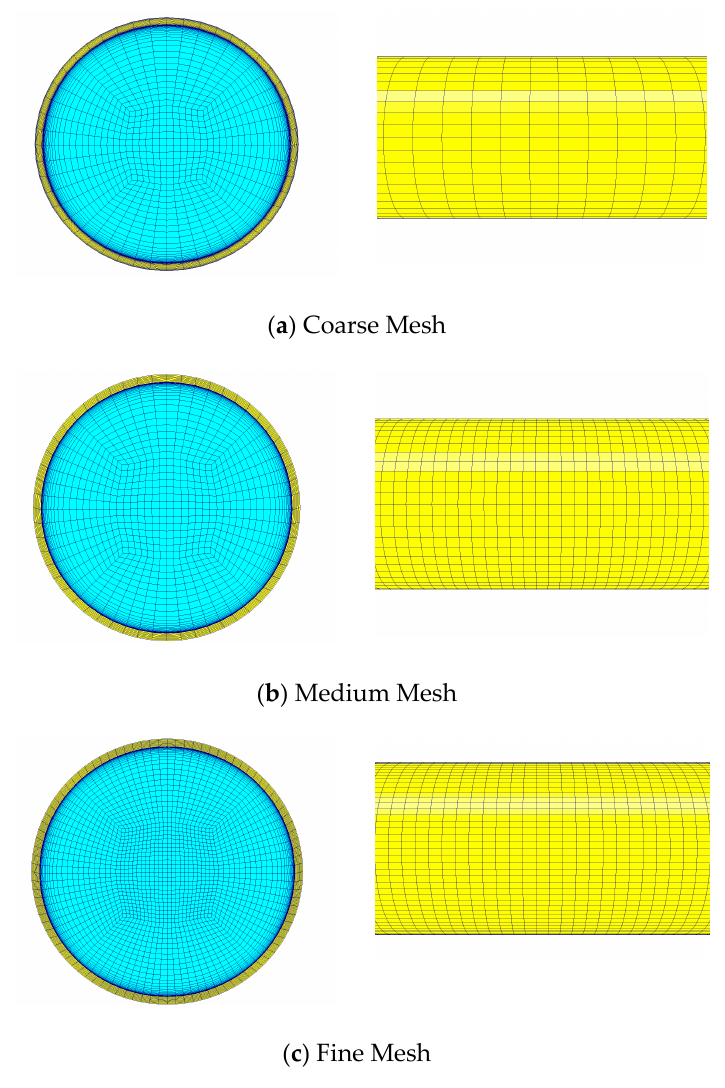
Figure 2. Three dimensional hexahedral meshes used in this study.